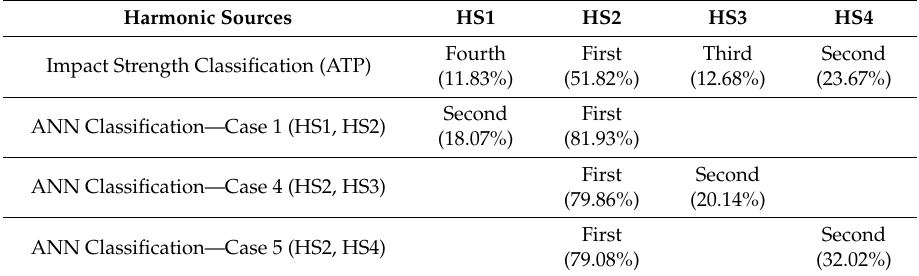
Table 5. Percent impacts on voltage harmonic distortions due to combinations of two harmonic sources and respective impact strength